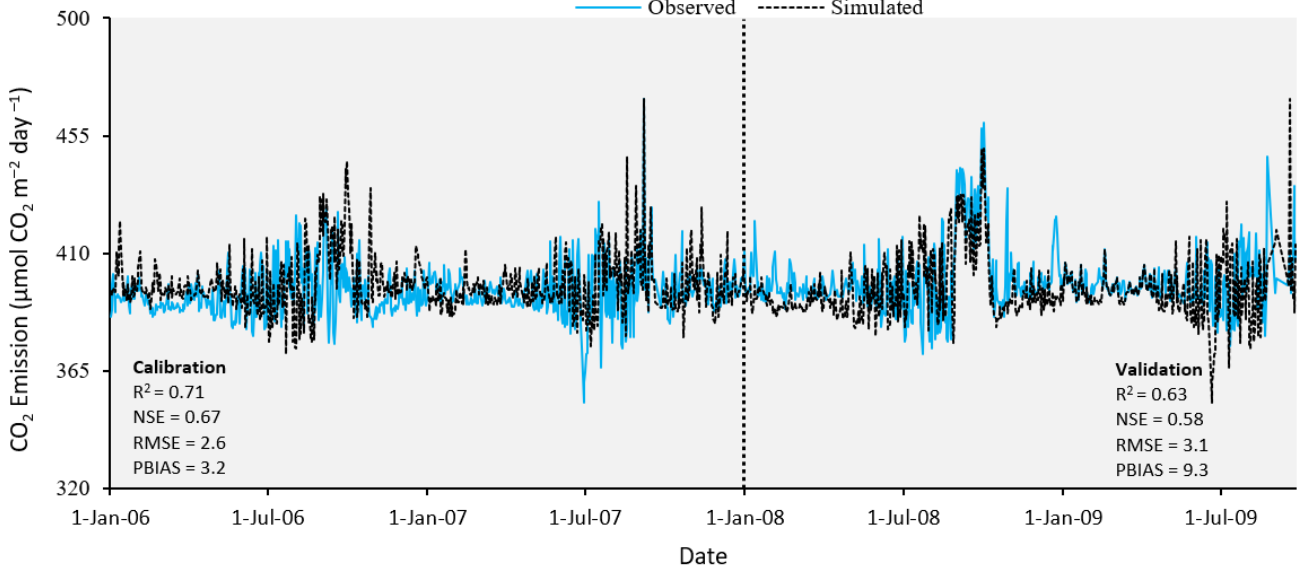
Figure 9. Predicted and observed daily CO 2 emission in the calibration and validation periods.